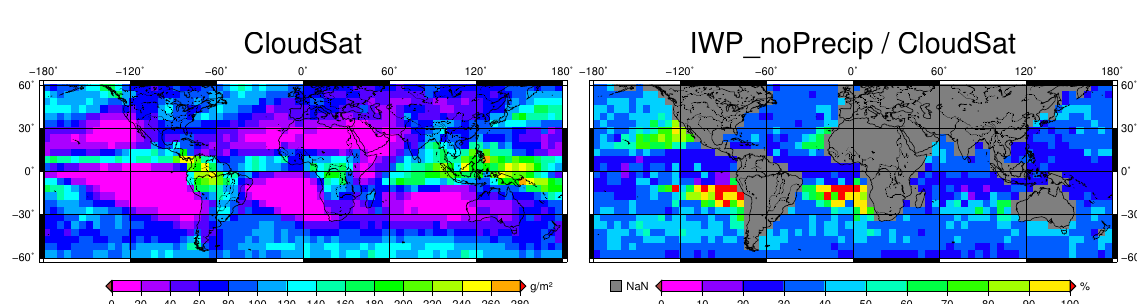
Fig. 4. CloudSat IWP (left), and the ratio (%) of CloudSat IWP noPrecip and IWP (right) from the period July 2006–June 2009.